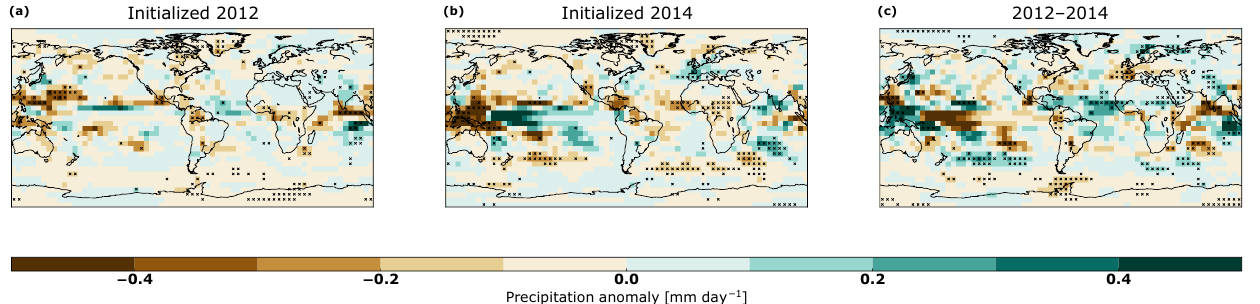
Figure 9. Same as Fig. 7, but for precipitation (PR)